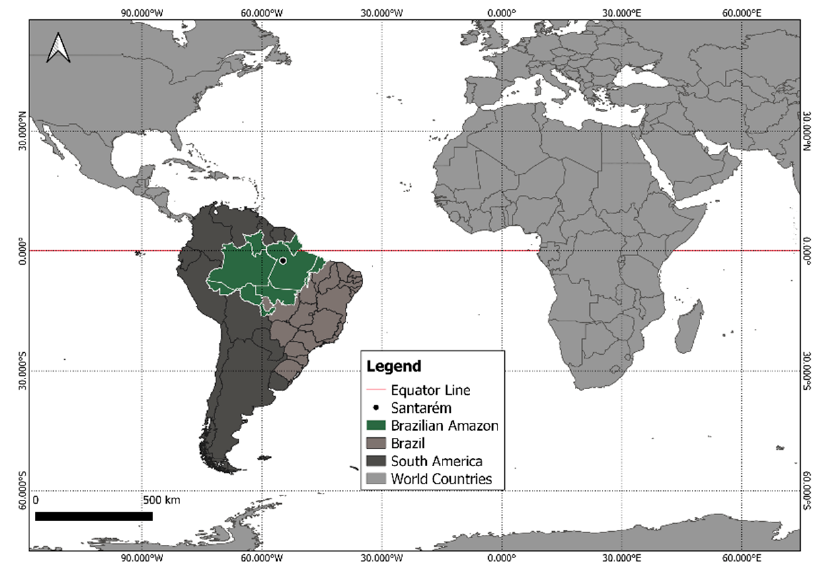
Figure 1. Map showing the location of Santarém in north Brasil.